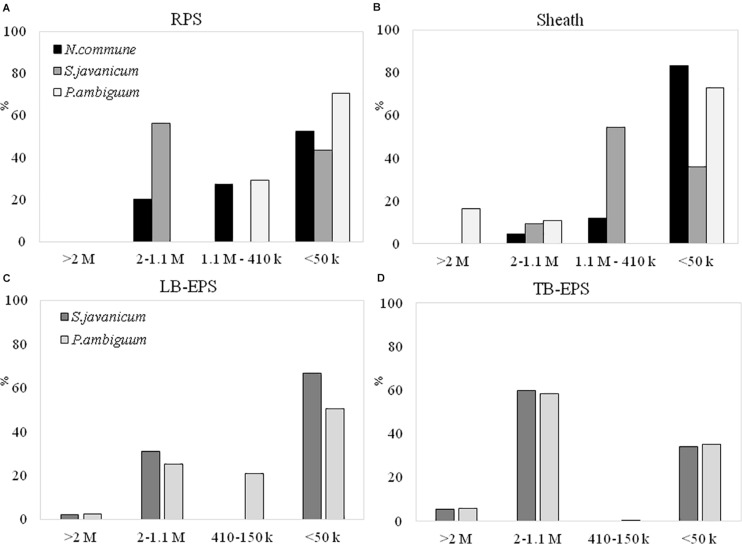
MW distribution of the EPS extracted from liquid culture: (A) RPS, (B) sheath, and from sandy soil microcosms: (C) LB-EPS; (D) TB-EPS, of the cultured strains. Relative proportions (%) of MW classes are represented. No data are reported for N. commune in the sandy soil microcosms (C,D) because of the negligible amounts of EPS extracted (See Figure 5).